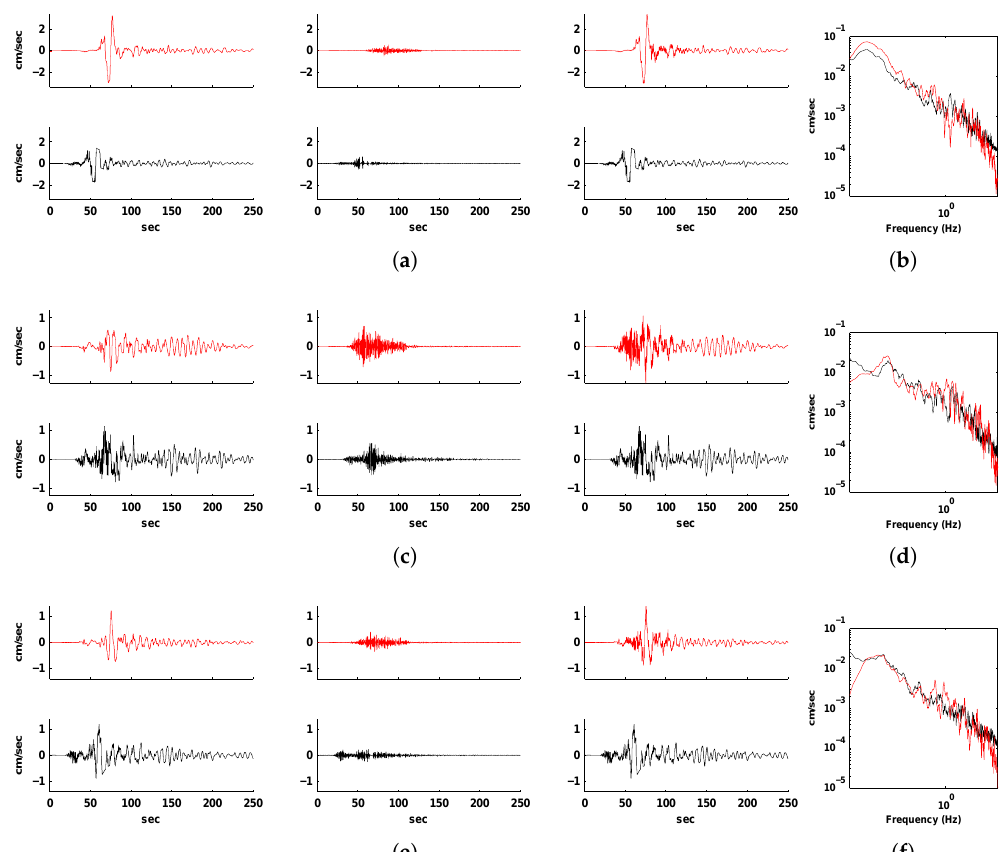
Figure 6. ( a ) North-south component, ( c ) east-west component, and ( e ) vertical component of ground velocity histories at Station 9. Shown in red are the long-period spectral-element-simulated (column 1), high-frequency EGF-synthesized (column 2), and combined broadband histories (column 3) for the 1999 Hector Mine earthquake. Shown in black are the corresponding filtered observed ground velocity records for comparison. ( b , d , f ) show the comparison of the corresponding spectra of the broadband velocity histories (red: synthesized, black: observed).